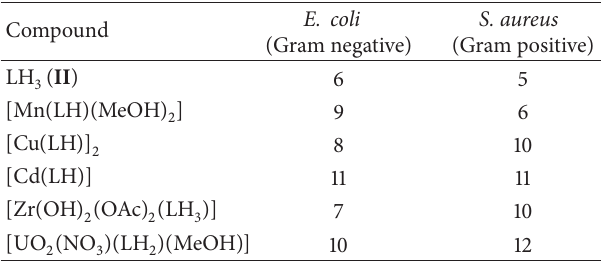
Table 3: Antibacterial activity of ligand ( I ) and its coordination compounds (zone of inhibition in mm).